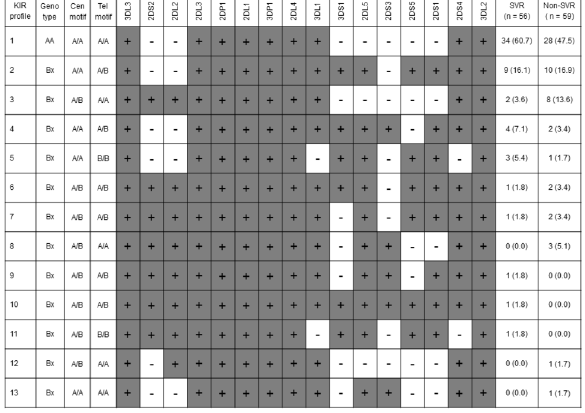
Figure 3. KIR gene profile frequencies in 56 patients with a sustained virological response (SVR) and 59 patients with a non-SVR to pegylated interferon and ribavirin therapy of chronic hepatitis C. Numerical data represent the number of individuals (%). The presence of KIR genes is indicated by gray shading. Cen, centromeric; Tel, telomeric.